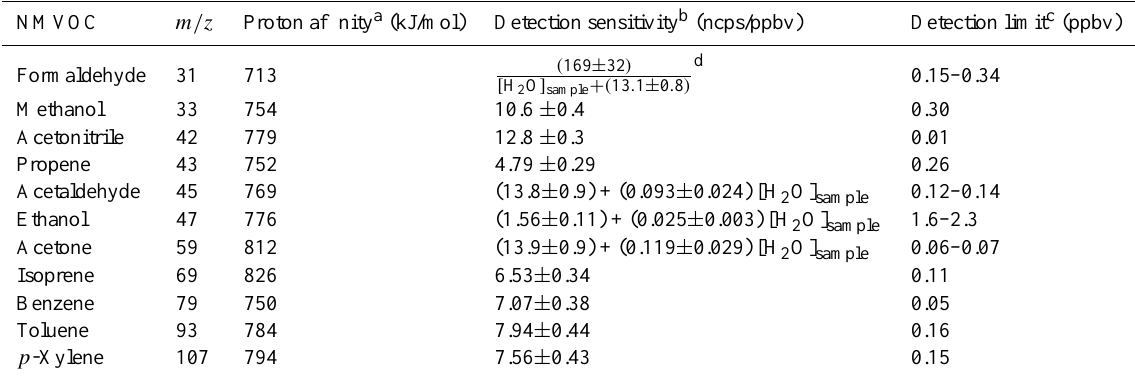
Table 3. Detection sensitivity, its humidity dependence, and detection limit for eleven